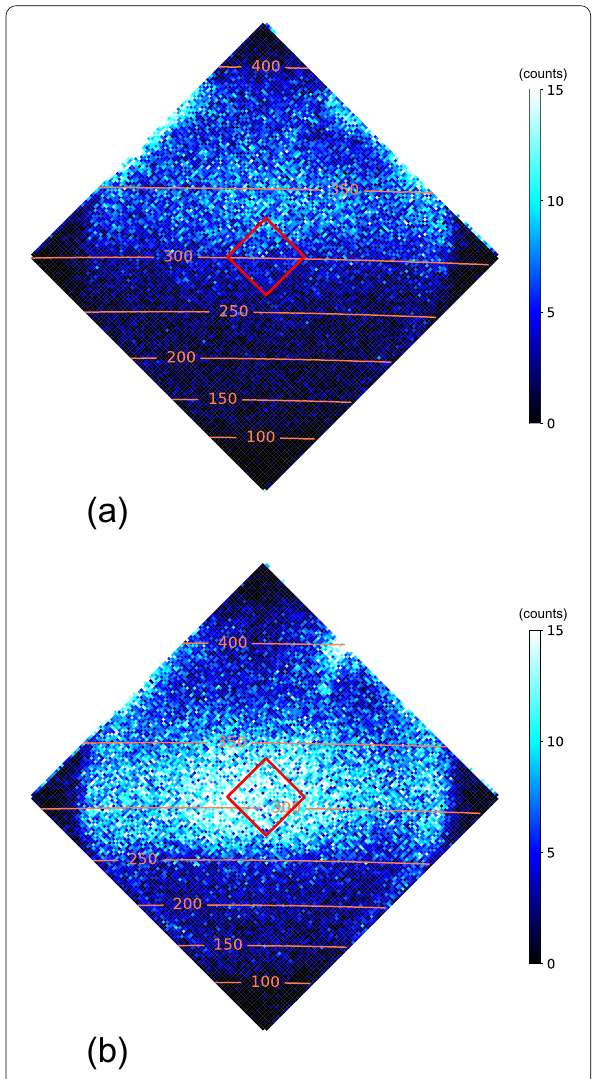
Fig. 1 EUV image taken from EUVI-B during 21:08:26–21:09:25 UT ( a ) and 21:18:38–21:19:37 UT ( b ) on December 26, 2012. The red square in each panel indicates the region where the EUV count is averaged to obtain Fig. 3. The orange contours in each panel indicate the altitude (in km ) at the tangential point along the line of